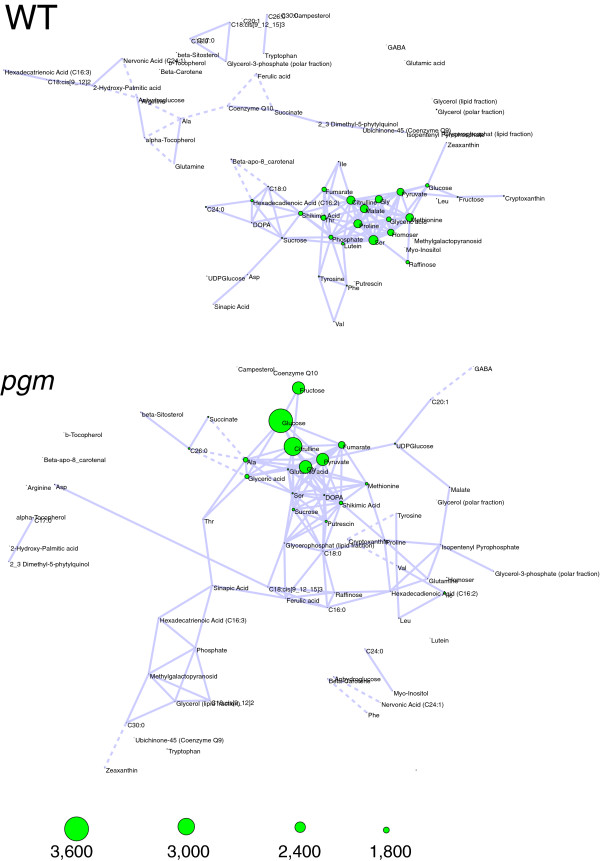
Metabolite correlation networks resulting from diurnal changes. Correlation networks of 137 metabolites determined across a day and night cycle in Arabidopsis Col0 WT plants and pgm growing in 12 h day/12 h night cycles. Metabolites with significant correlations are linked together; green discs represent the number of transcripts correlated to a given metabolite. Solid lines indicate positive correlations, dotted lines indicate negative correlations.